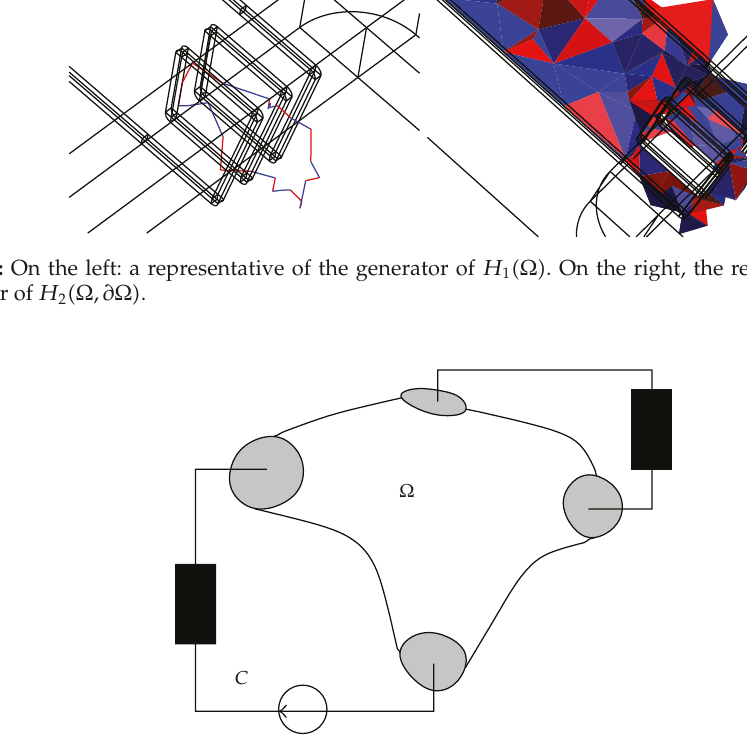
Figure 8: Coupled field-circuit problem. The circuit and field domains are isolated everywhere else except on the shaded region Γ ⊂ ∂ Ω